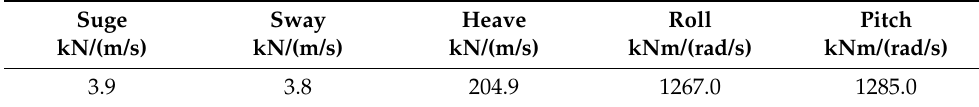
Table 10. Viscous damping coefficients of mooring buoy system.